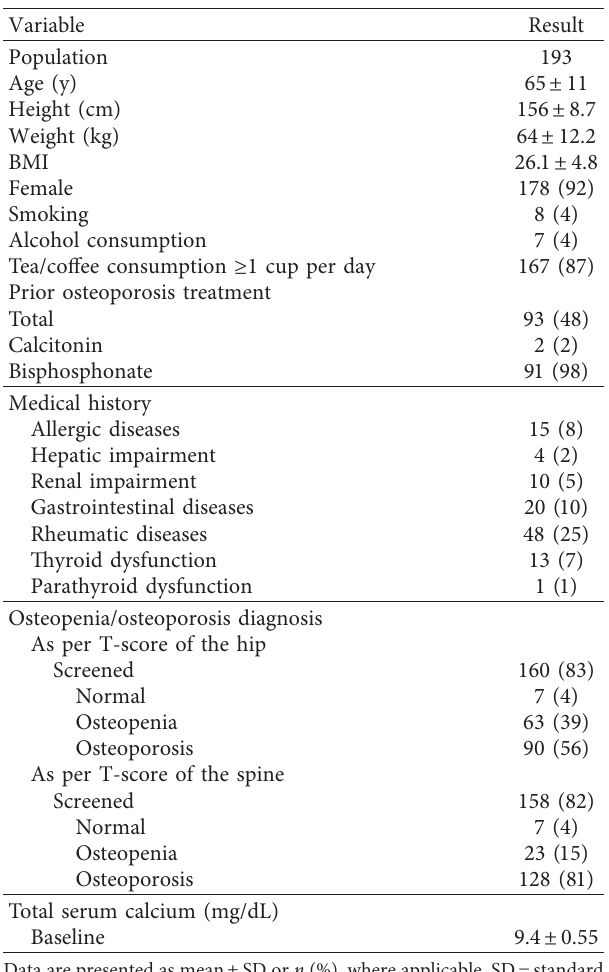
Table 1: Patients’ demographic and baseline